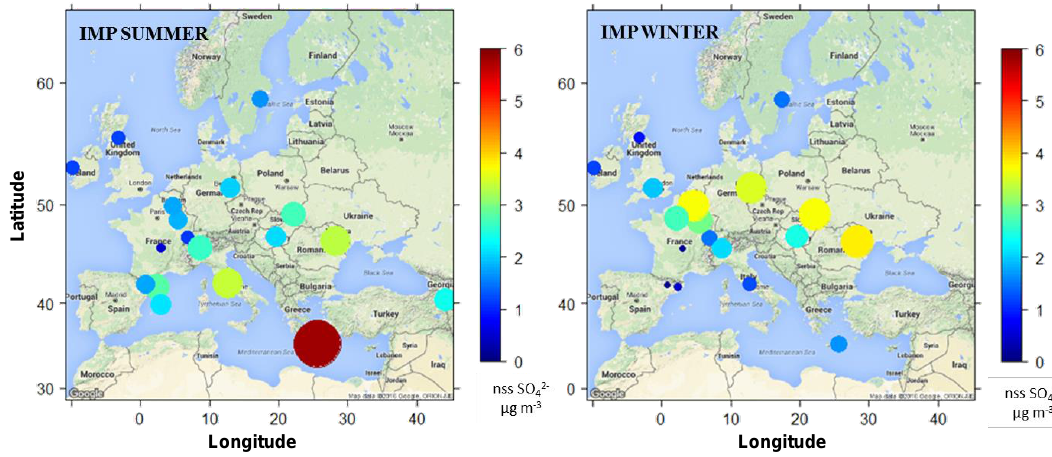
Figure 11. Spatial distribution of the mean nss-sulfate concentrations (µgm − 3 ) during the summer 2012 and winter 2013 EMEP IMPs. The diameter of the circles is proportional to the concentrations.